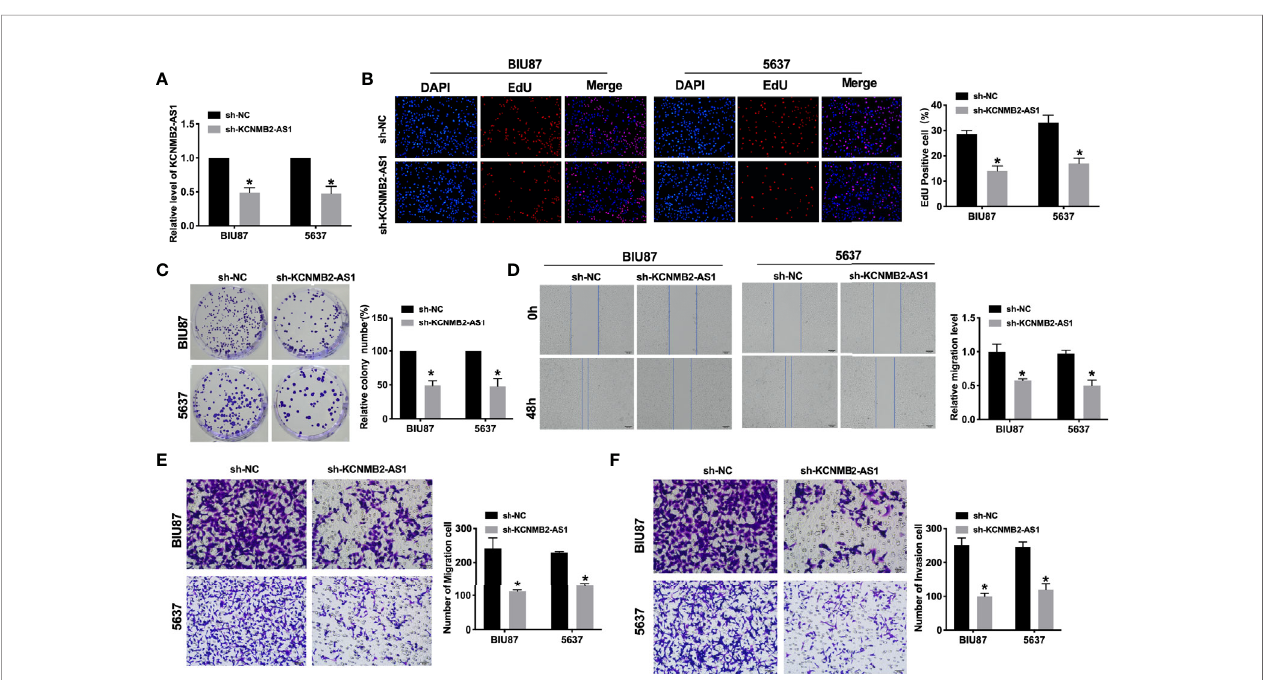
FIGURE 2 | Inhibition of KCNMB2-AS1 attenuated bladder cancer cell proliferation, migration, and invasion. (A) Transfection ef fi ciency was detected by RT-PCR. n = 10. (B) EdU incorporation of cancer cells was used to measure cell proliferation rate. n = 8. (C) Clone formation capacity of BIU87 and 5637 cells was assessed by the clone formation assay. n = 5. (D) The typical pictures of Scratch-wound healing assay. (E) Tumor cell migration study via transwell assay. n = 6. (F) Detecting cell invasion by Transwell invasion assay. n = 6. * P < 0.05.